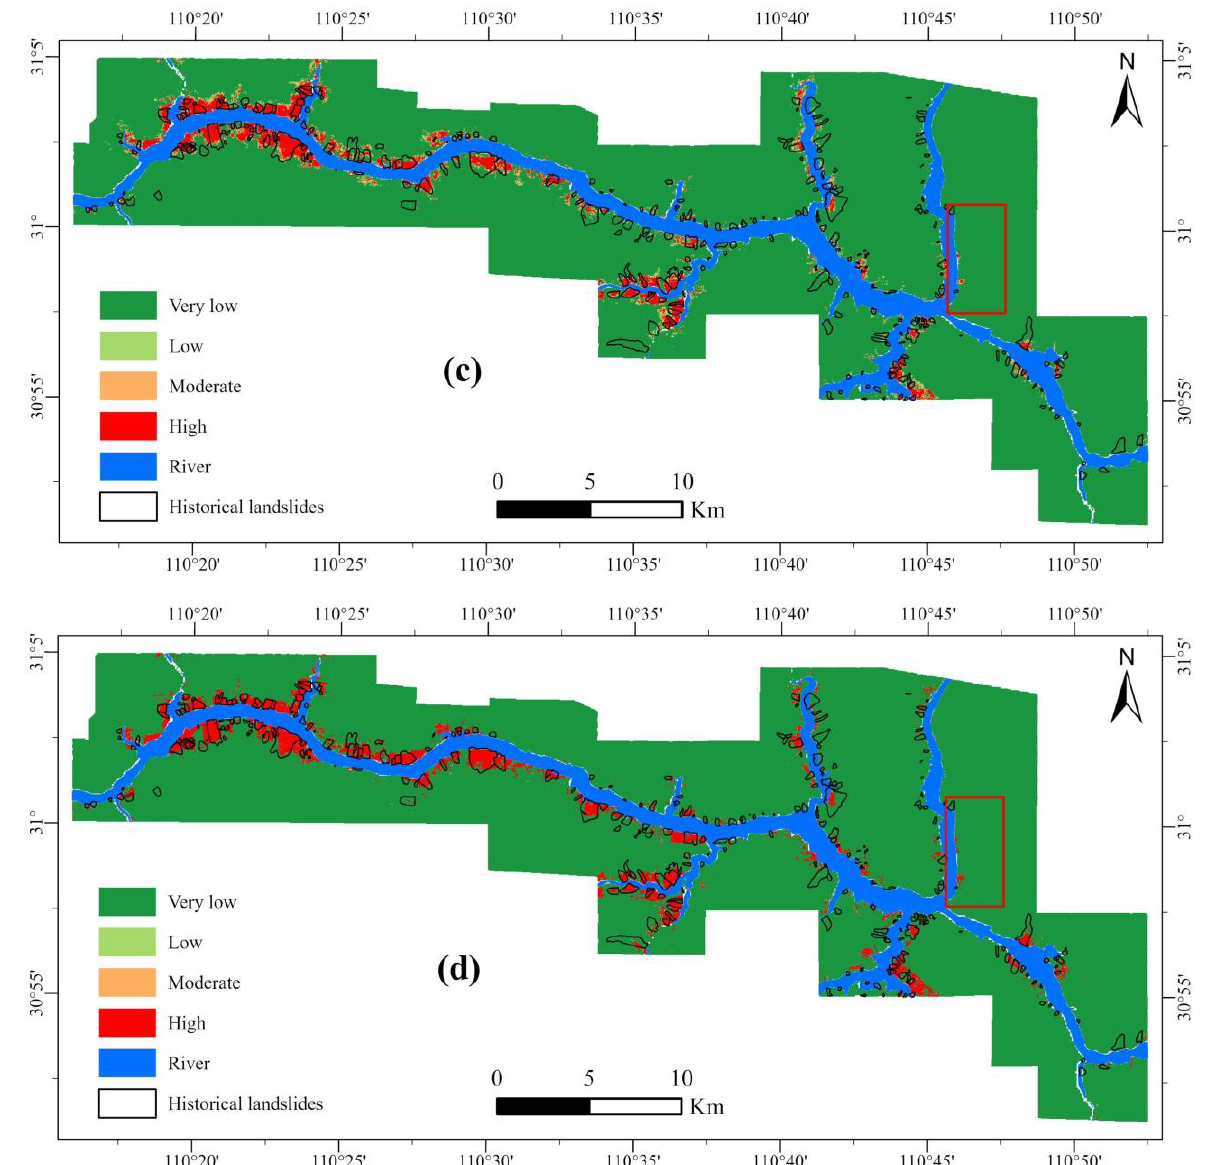
Figure 12. LSA results under the class imbalanced strategy: ( a ) result of LR, ( b ) result of RF, ( c ) result of DFCNN, ( d ) result of LSTM.